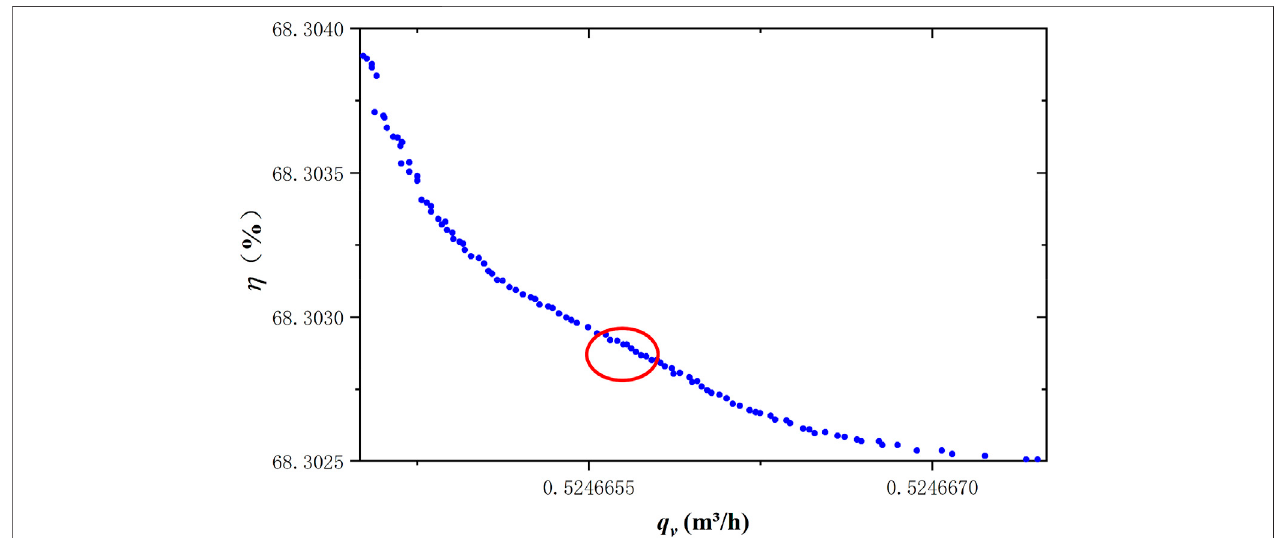
FIGURE 14 | Pareto